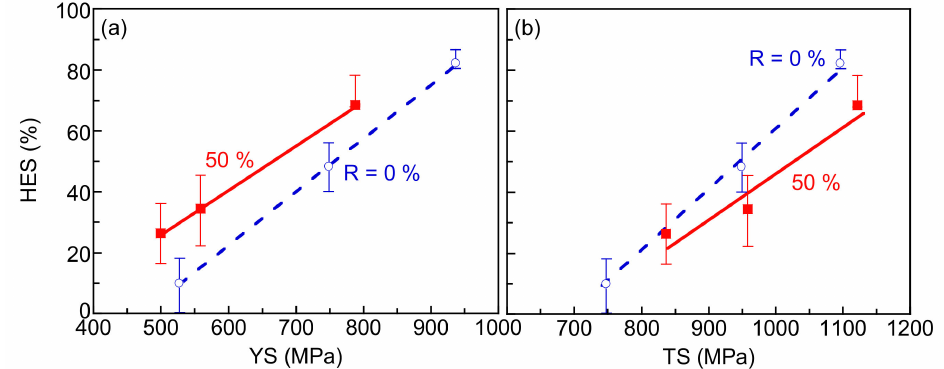
Figure 6. Variations in hydrogen embrittlement susceptibility ( HES ) as functions of ( a ) yield strength ( YS ) and ( b ) tensile strength ( TS ) in conventional and hot-forged steels A, B, and C. R represents reduction ratio.